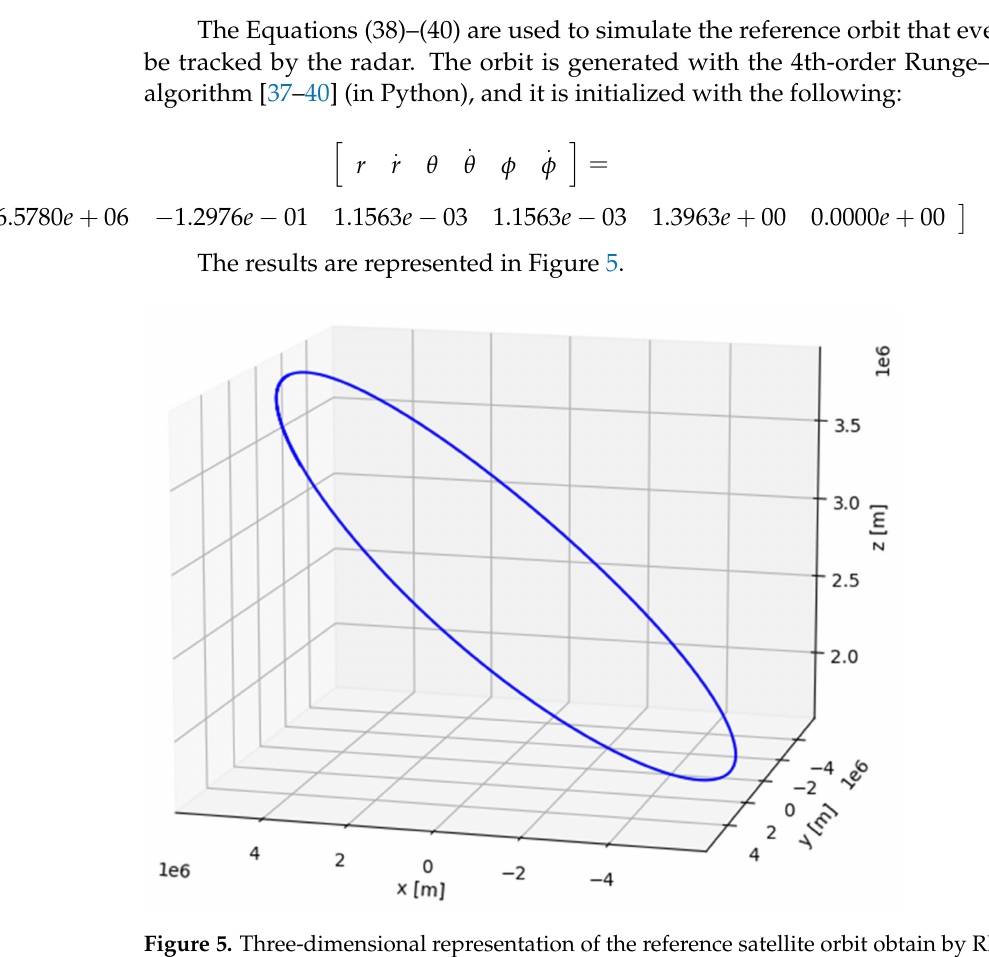
Figure 5. Three-dimensional representation of the reference satellite orbit obtain by